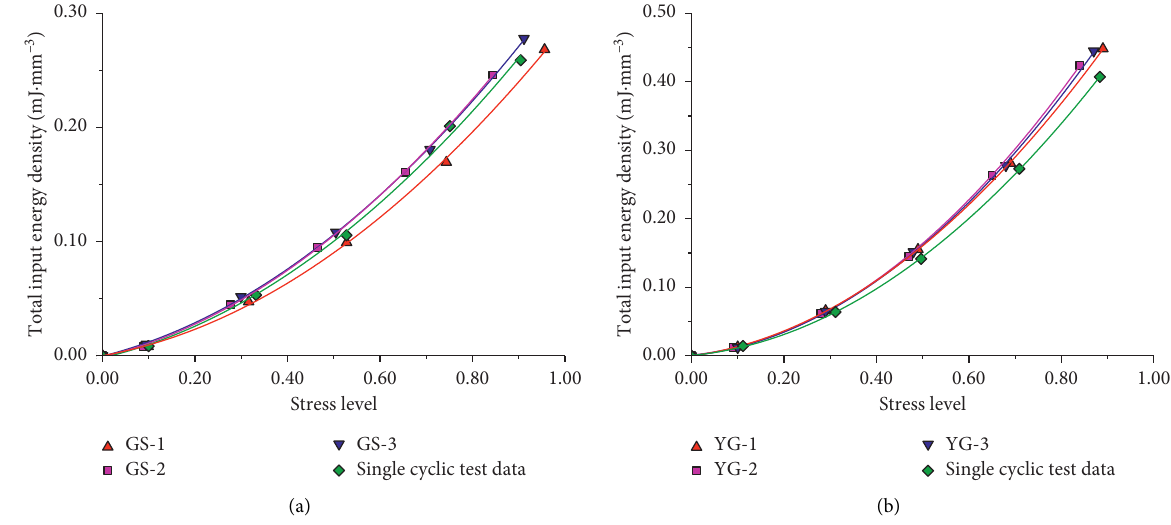
Figure 7: Variation tendency of total input energy density with the stress levels in approach 2. (a) Green sandstone; (b) Yueyang